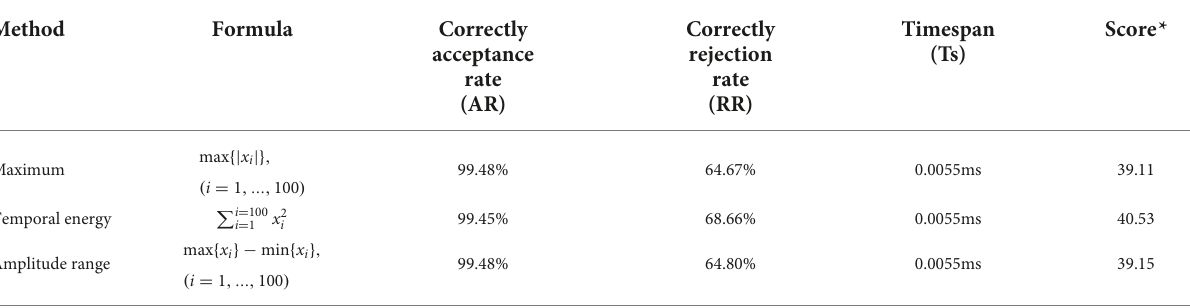
TABLE 4 Comparison among different threshold setting methods.